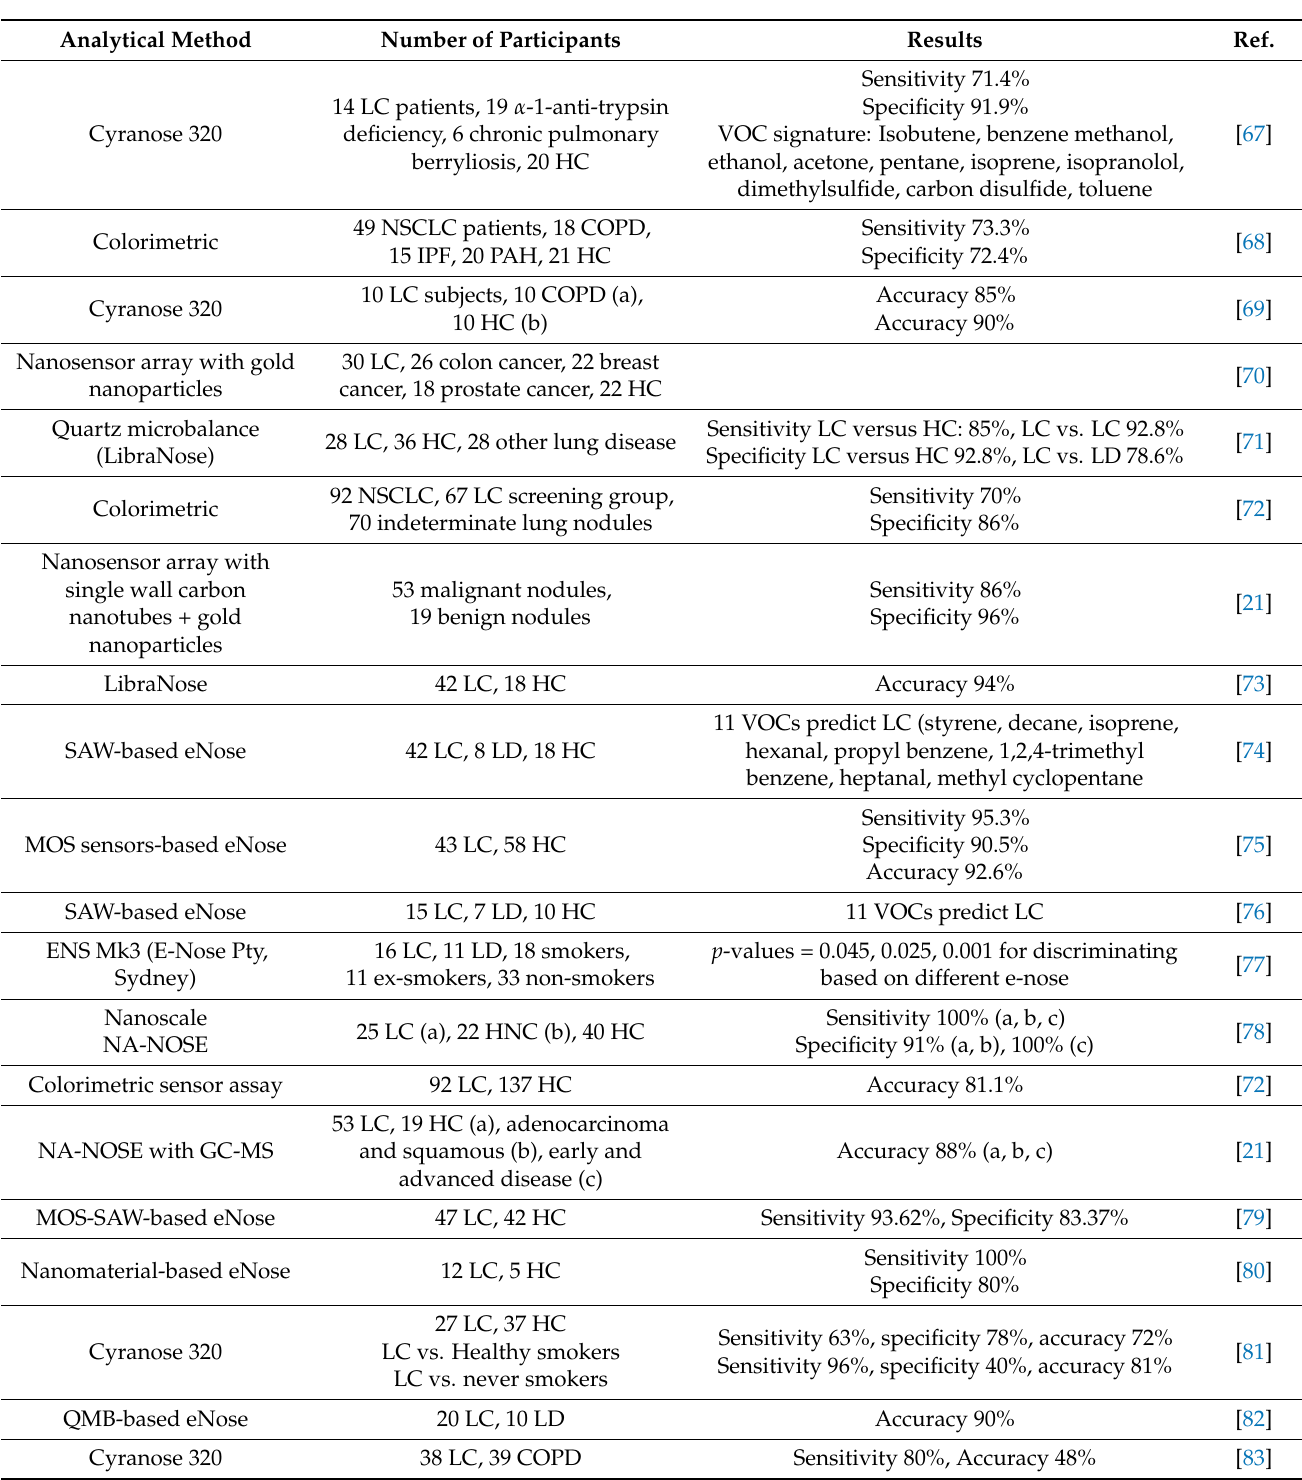
Table 2. Summary of clinical studies using e-Nose technology in lung cancer. Abbreviations: LC: lung cancer; NSCLC: non-small cell lung cancer; COPD: chronic obstructive pulmonary disease; IPF: idiopathic pulmonary fibrosis; PAH: pulmonary arterial hypertension; LD: lung disease; SAW: surface acoustic wave; MOS: metal oxide semiconductor; QMB: Quartz